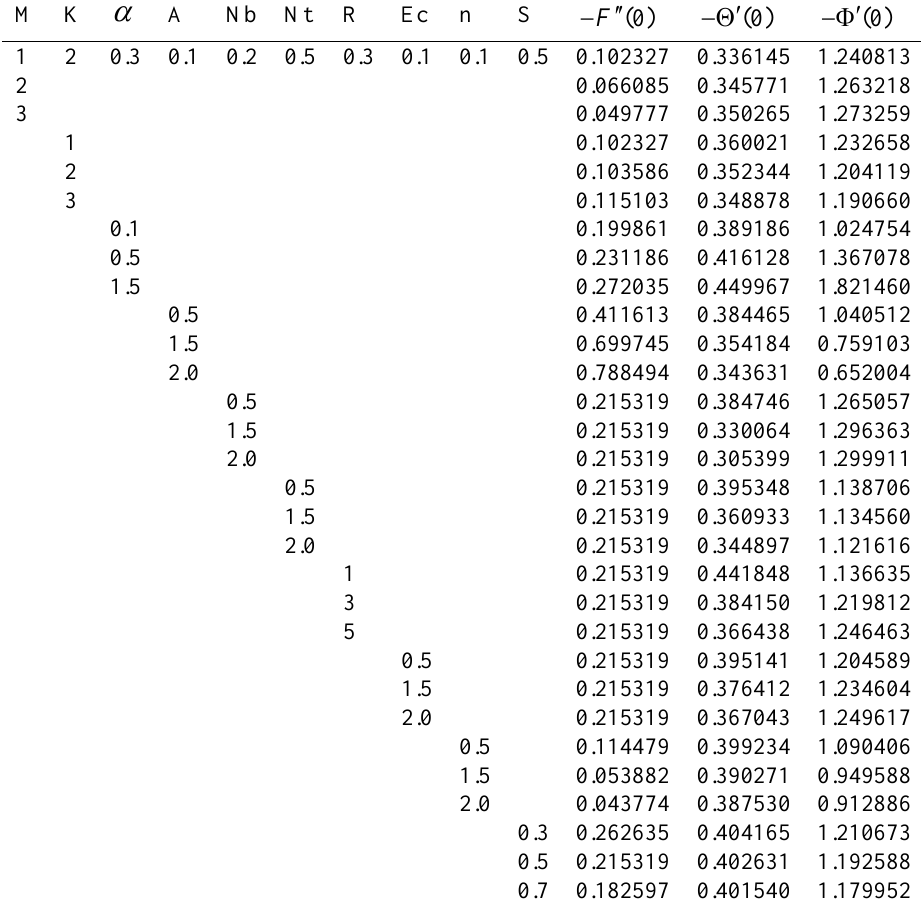
Table 1. Numerical values of